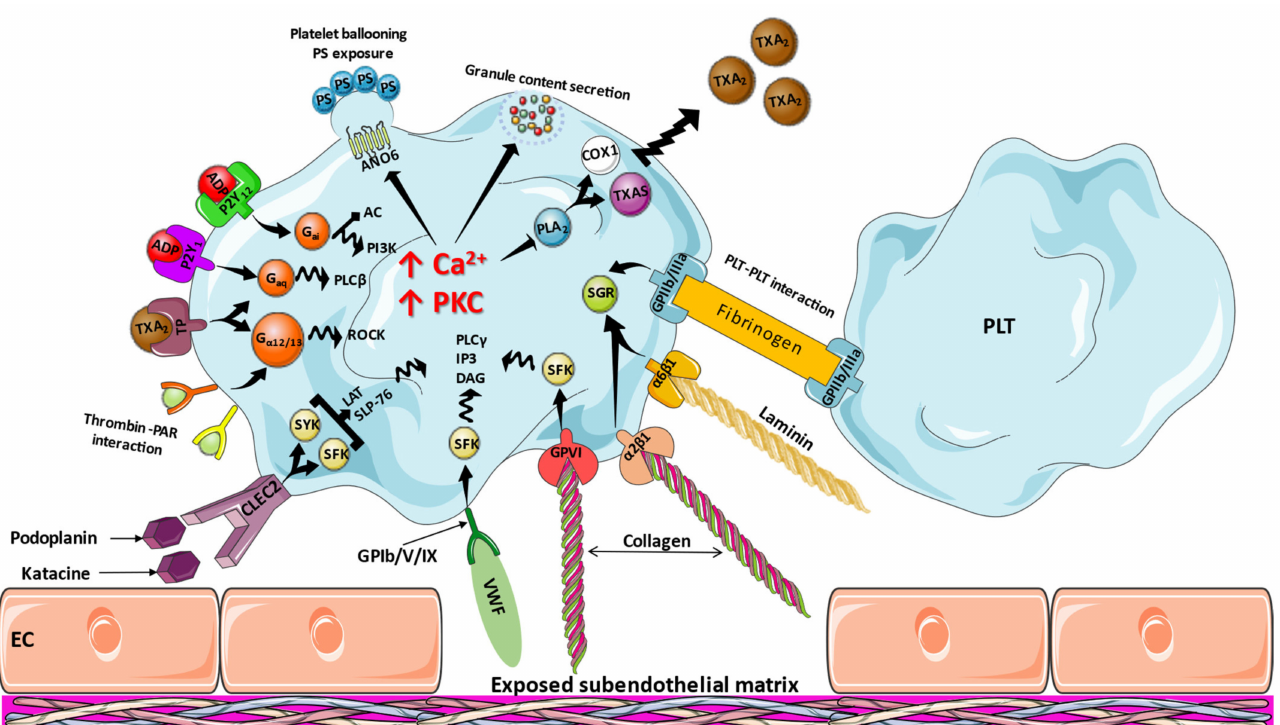
Figure 1. Mechanisms of platelet activation. AC: adenylyl cyclase, ADP: adenosine diphosphate, ANO6: anoctamin 6, CLEC2: C-type lectin-like receptor 2, COX1: cyclooxygenase 1, DAG: